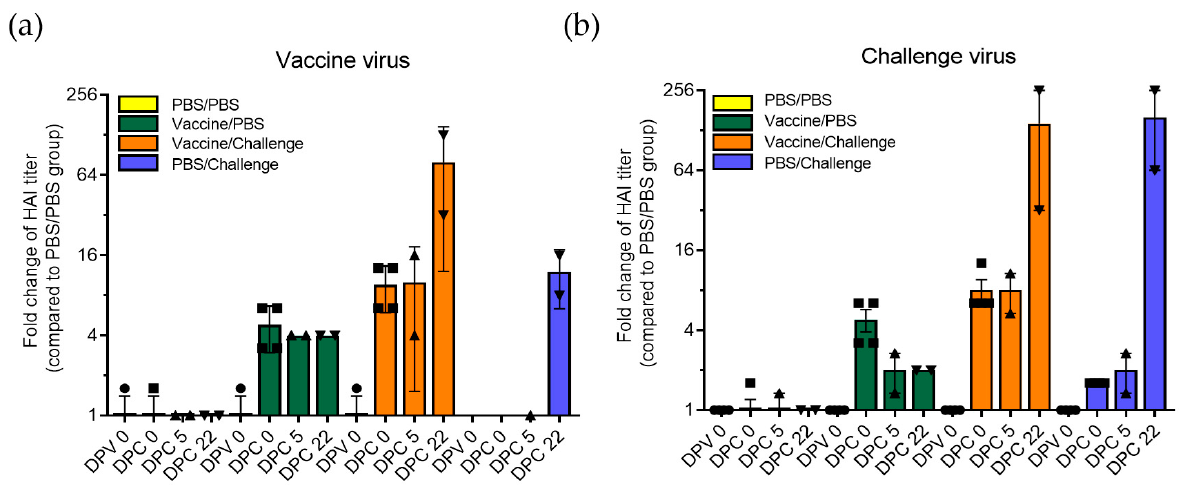
Figure 2. Comparison of HAI antibody titers in serum from different groups of sows. Four sows from each group were vaccinated twice with inactivated TX98-129 or PBS and further challenged with either influenza virus or PBS as control. Serum samples were collected at 0, 5, and 22 DPC and subjected to HAI assay against the vaccine virus (TX98-129, ( a )) and challenge virus (IL13, ( b )). HAI titers are defined as the reciprocal of the final serum dilution where inhibition of hemagglutination was observed. Fold-change of HAI titer compared to PBS/PBS group was calculated and plotted. Mean values and standard deviation of each time point of different treatment groups are indicated. Black circle, square, up-pointing triangle, and down-pointing triangle represent serum samples collected from DPV 0, DPC 0, DPC 5, and DPC 22, respectively.